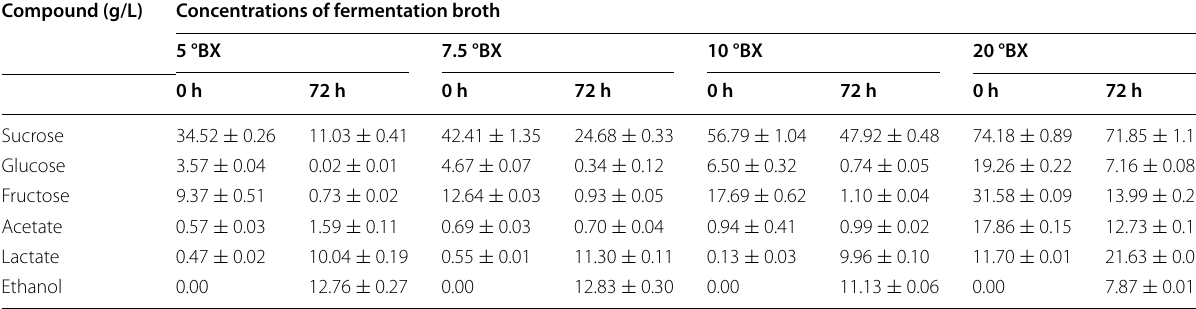
Table 2 Carbohydrate metabolism in four low concentrations of cane molasses Compound